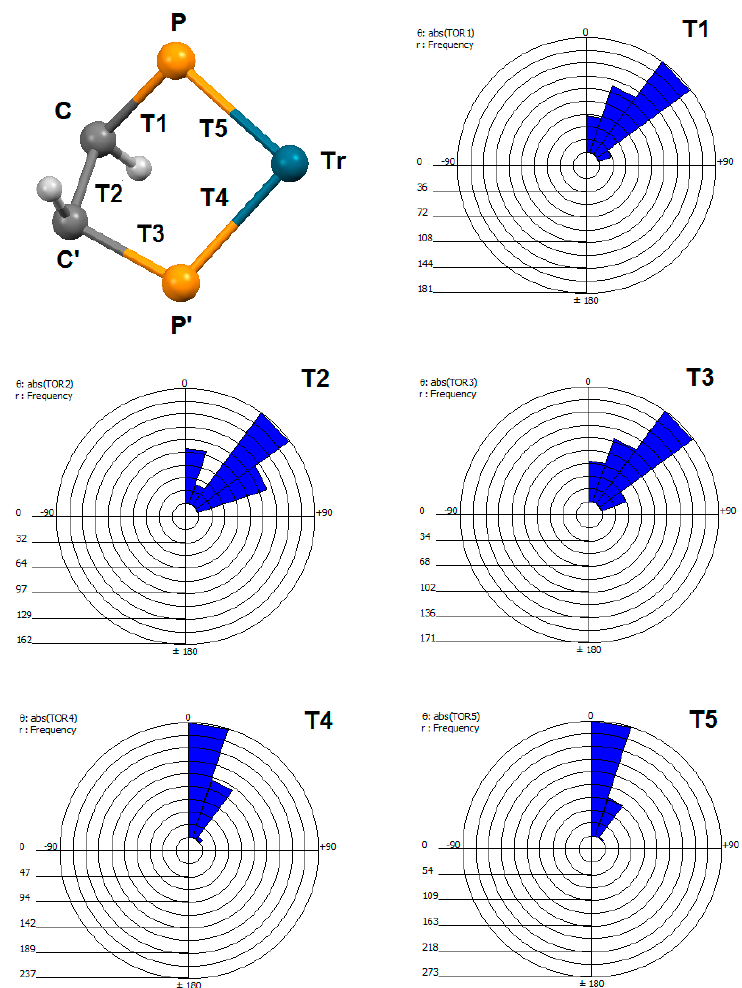
Figure 4. Distribution of the torsion values T1–T5 in the structures of five-membered metallacycles in the complexes of transition metals (Tr) with bis(phosphane) ligands found in the CSD